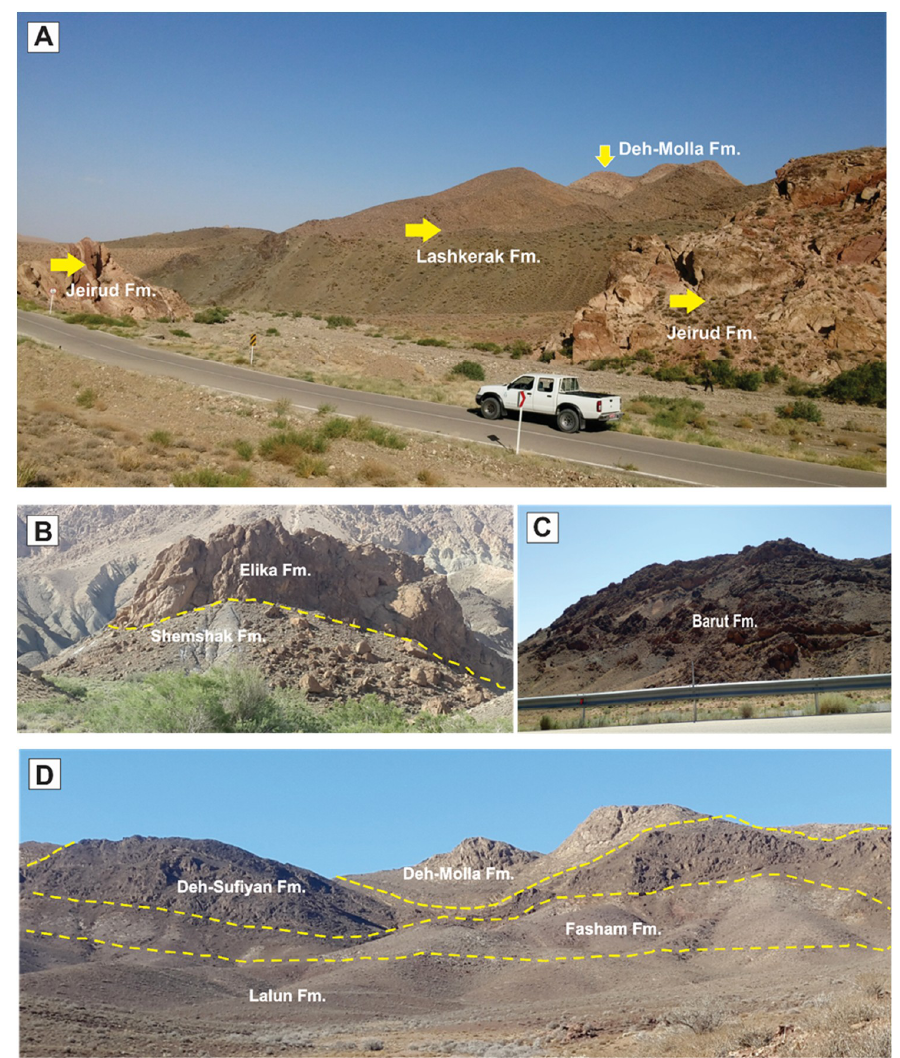
Figure 3. Outcrops of sedimentary lithological units in the Deh-Molla area. ( A ) Panoramic view of the Jeirud, Lashkarak, and Deh-Molla formations (Mila group); ( B ) carbonates of the Elika Formation showing fault contact with the Shemshak Formation; ( C ) dolomite and shales of the Barut Formation; and ( D ) panoramic view of the Lalun, Fasham, Deh-Sufyian and Deh-Molla (Mila group) Formations.